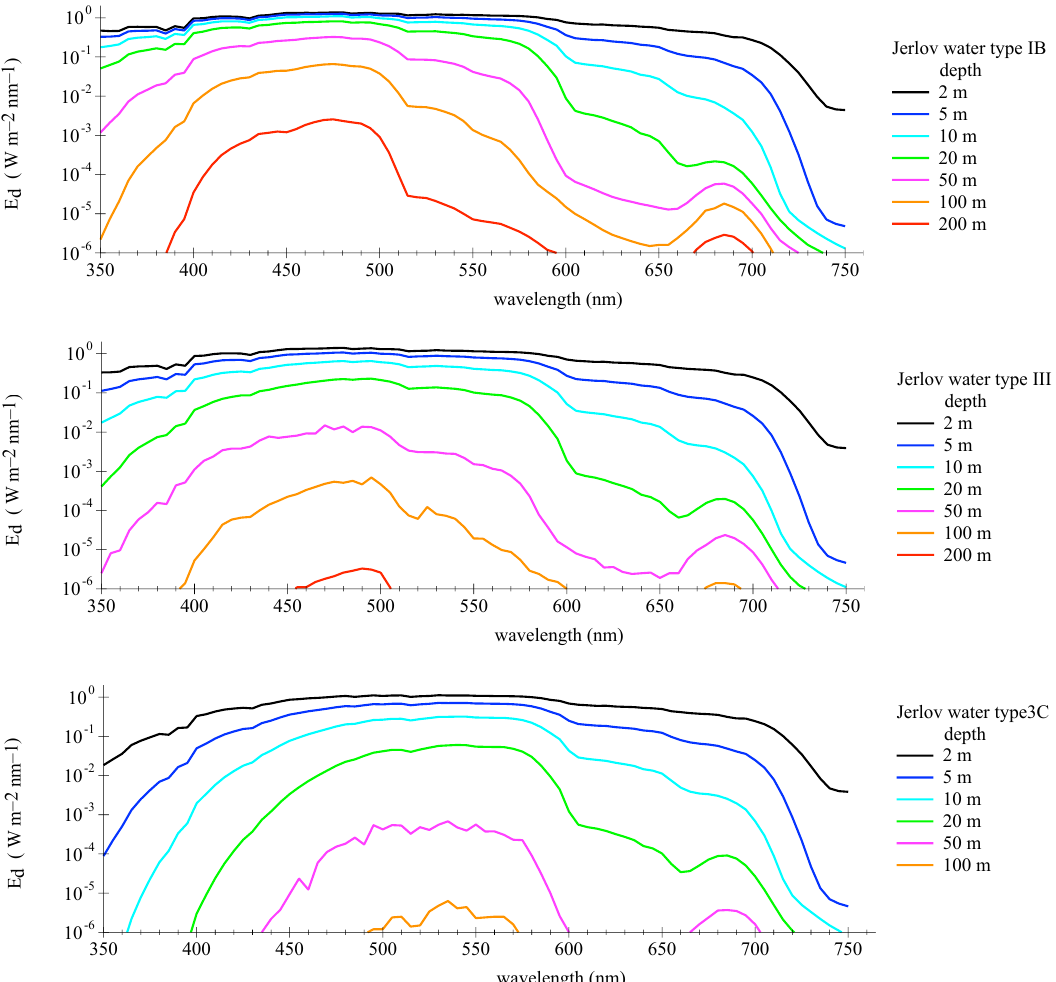
Figure 2. Spectral downwelling Irradiance E d as function of the water depth for three Jerlov water types, under following conditions: sun zenith angle at 30 ◦ , clear sky, wind speed 5